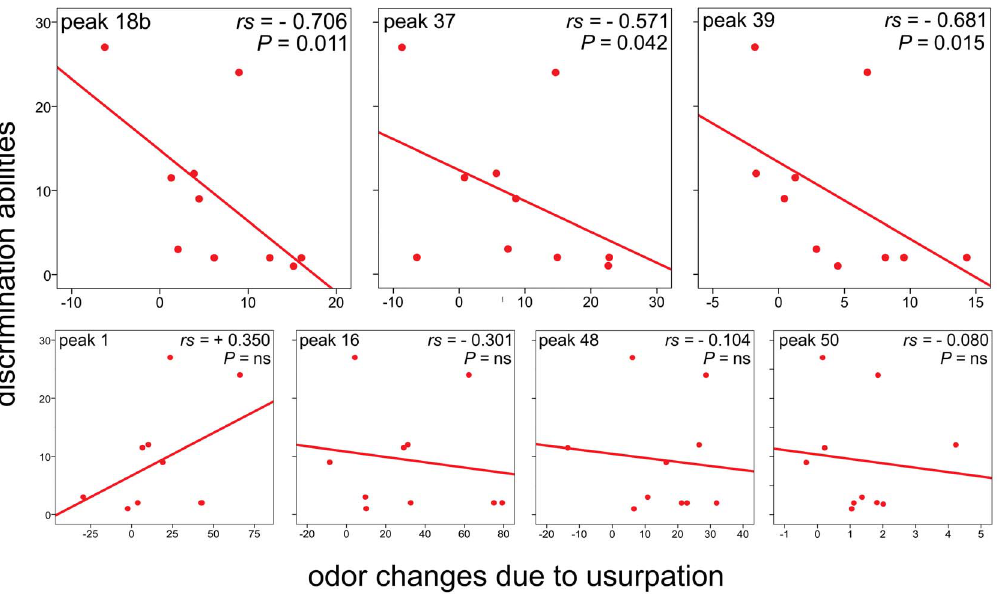
Figure 5. The relationship between discrimination abilities and odor changes due to usurpation. For peak 18b, 37 and 39, the correlation was significant: the discrimination abilities were the least where the relative odor changes due to usurpation were the largest. For peak 1, 16, 48 and 50, the correlation was not significant (discrimination abilities: attacks to P. nimphus non-nestmates; odor changes: difference between the concentration of the hydrocarbons in usurped and control nests; r=Spearman rho).